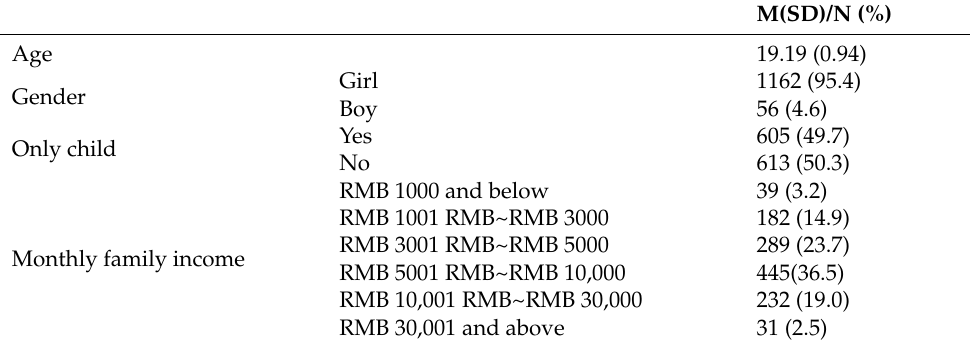
Table 1. The demographic information for participants ( n = 1218).